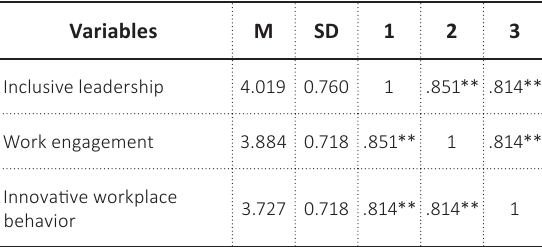
Table 2. Mean, standard deviations,